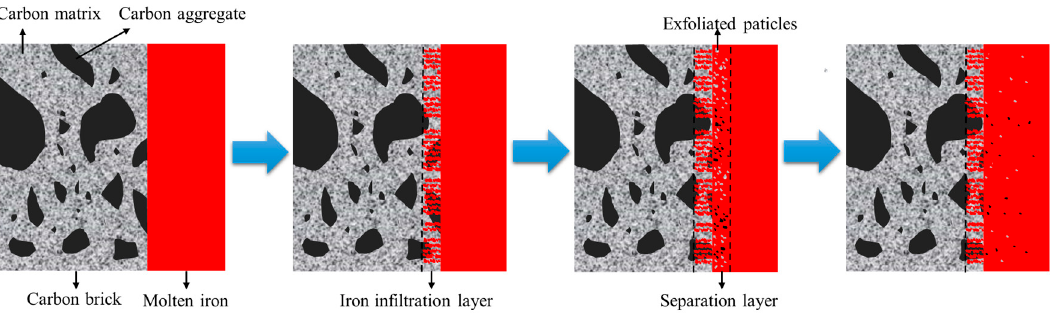
Figure 16. Schematic diagram of the corrosion mechanism of carbon brick in molten